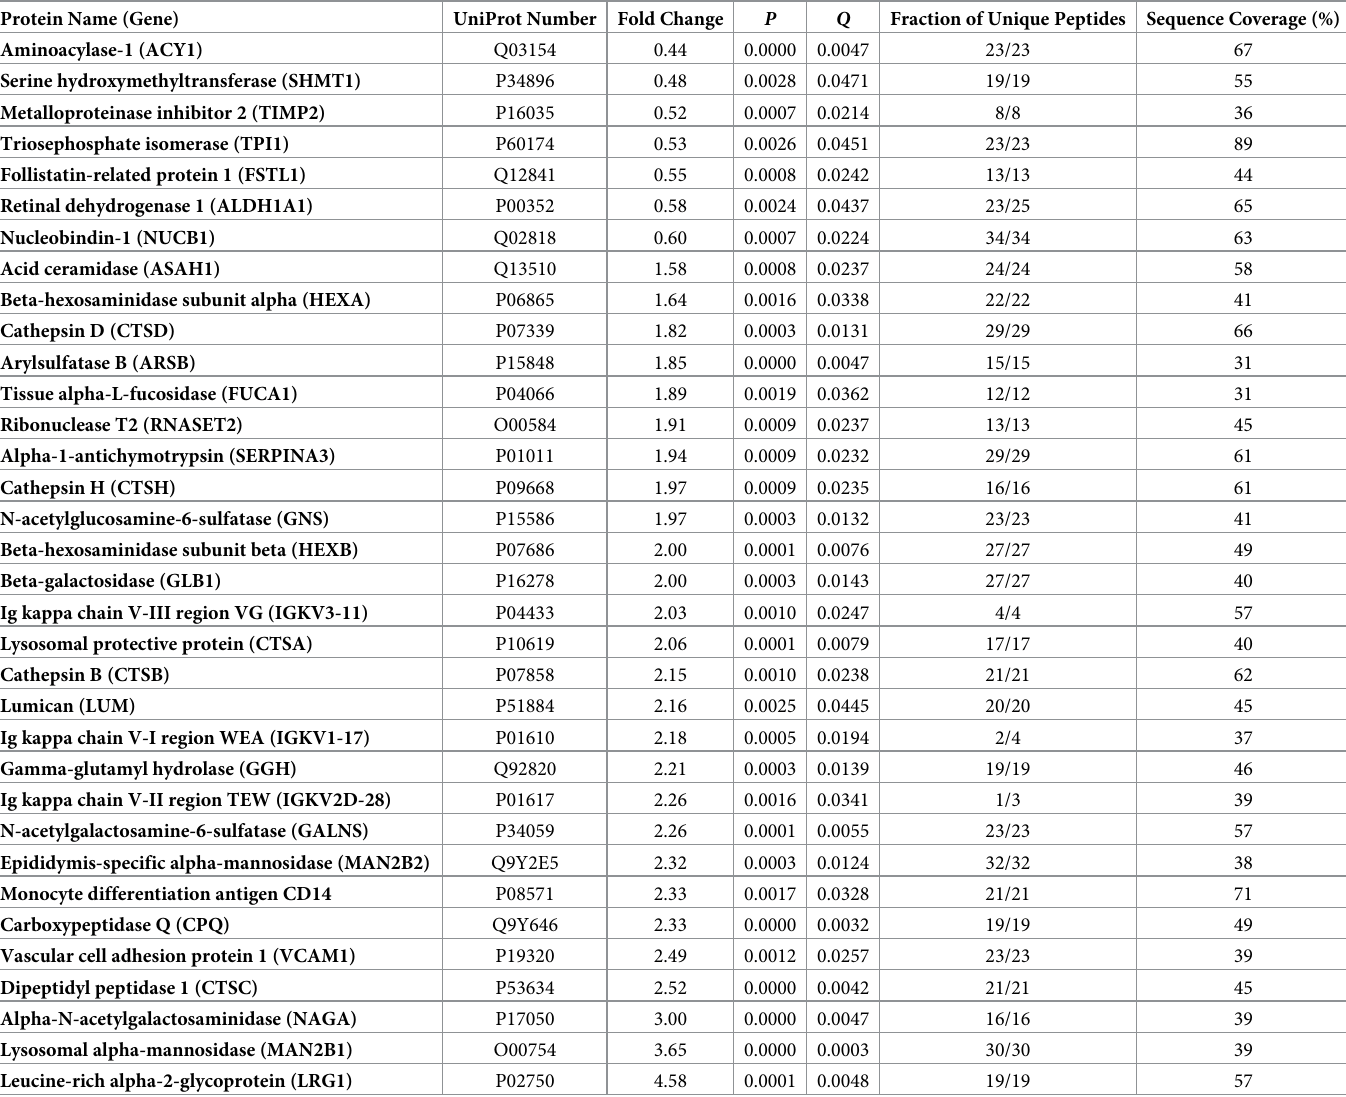
Table 2. Summary of urinary proteins significantly altered in early type 1 diabetes.